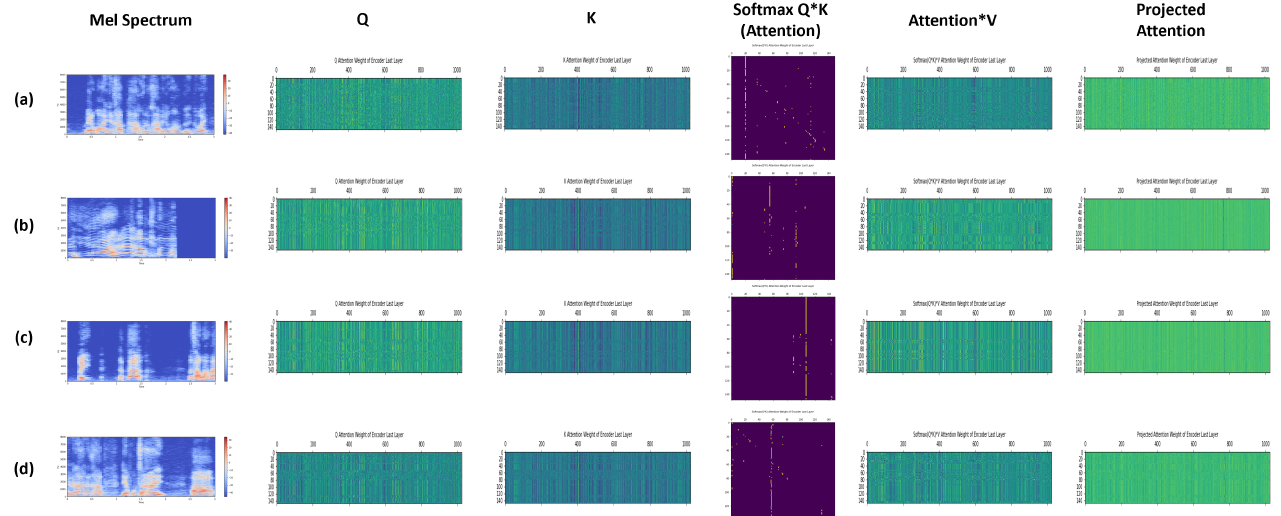
Figure 5. Attention weights of last layer encoded feature using transfer learning of Wav2Vec2 based on the ThaiSER dataset: ( a ) normal speech chunk, ( b ) chunk containing normal silence, ( c ) chunk containing mostly silence, and ( d ) chunk between speech. Please see the full resolution image in the supplementary material.